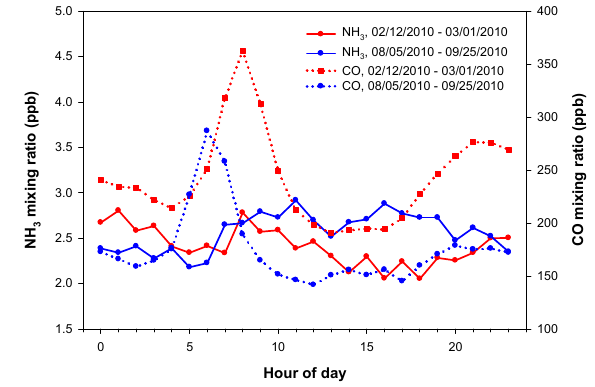
Fig. 5. Diurnal hourly average NH 3 and CO mixing ratios during the two sampling campaigns in Houston. As discussed in the text, outlier plumes are removed from this analysis in summer.